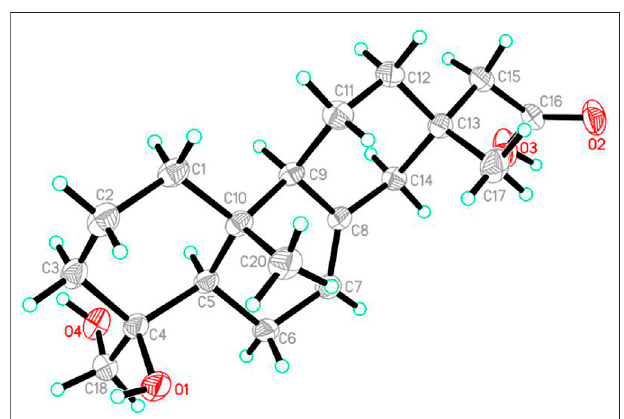
FIGURE 3 | OPTER drawing of compound 1